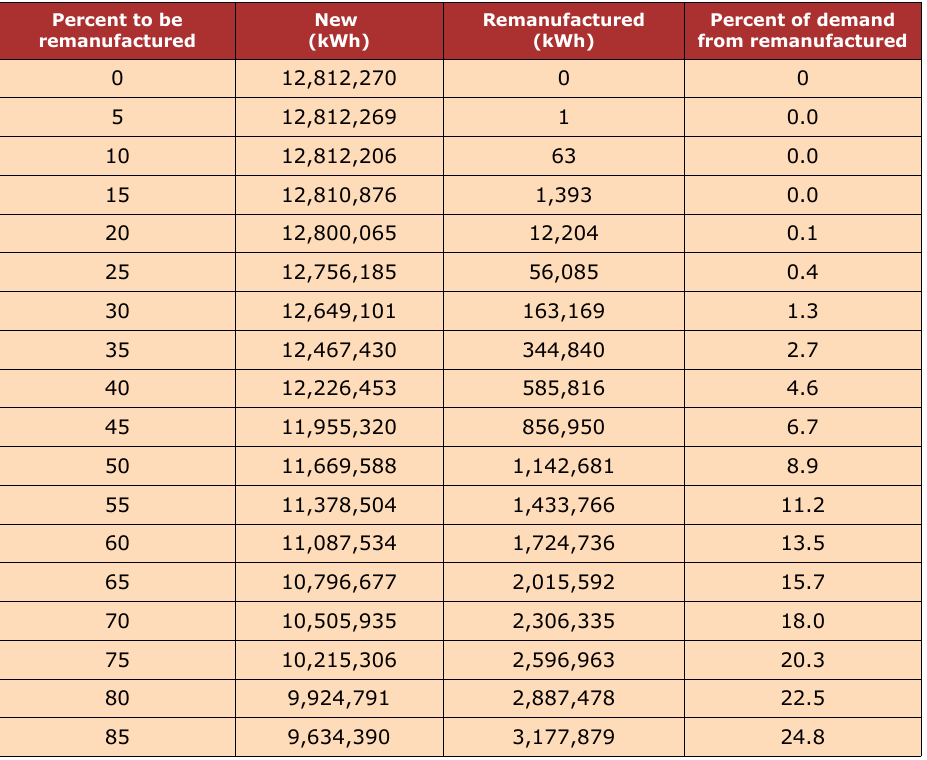
Table 7. New and remanufactured batteries by percent remanufactured – Simulation results for